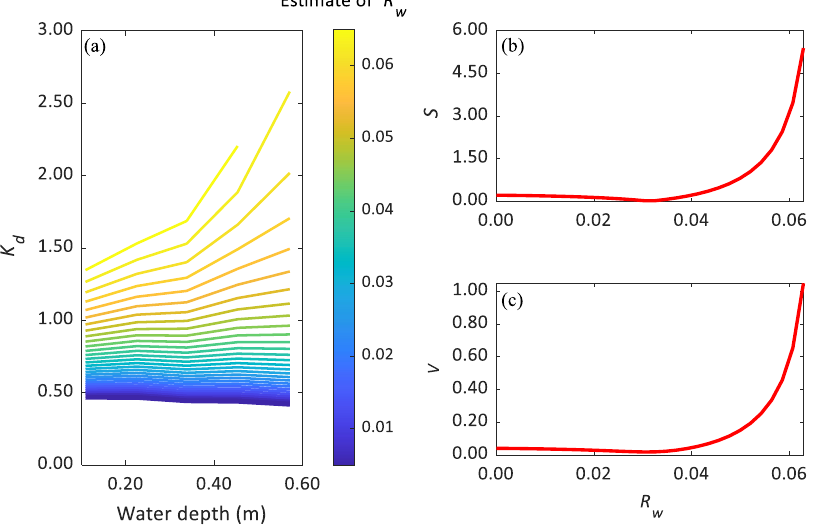
Figure 4. ( a ) The relationship between K d (Equation (3)) and z , where each line corresponds to a different estimate of R w (shown by the colour scale). The depths associated with areas that are exposed or covered by both sediments and vegetation are excluded. ( b , c ) are respectively the trend ( S ) and variance ( V ) of each line plotted in ( a ). S and V are evaluated over the same range of pixels as shown in ( a ) and clearly show a defined minimum corresponding to the true value of R w (0.031 in this example).